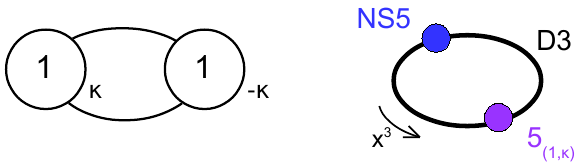
Figure 31 . Quiver and brane realization of the abelian ABJM theory at CS level (cid:20)